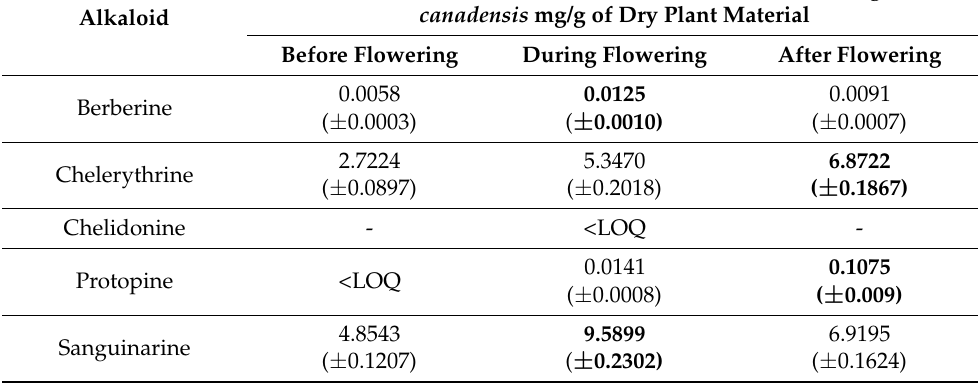
Table 2. Retention times of isoquinoline alkaloid standards and contents of isoquinoline alkaloids in Sanguinaria canadensis extracts